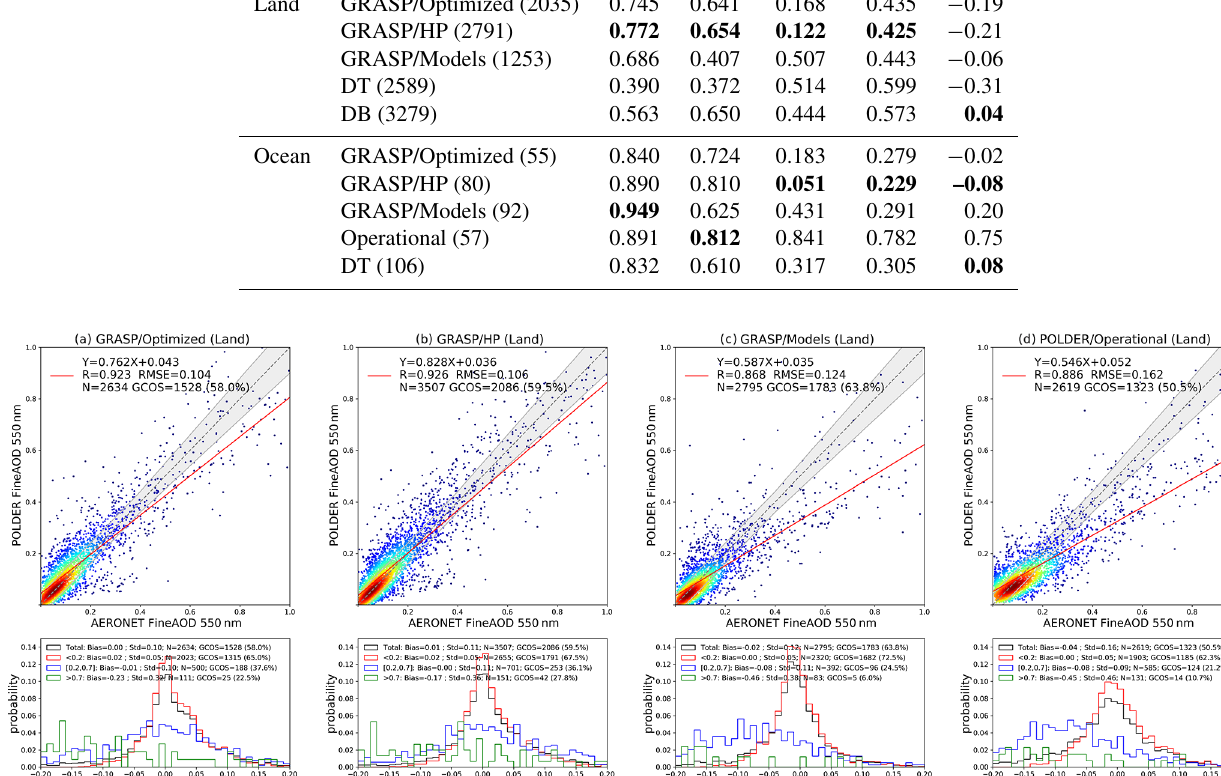
Figure 13. Validation of PARASOL/GRASP ( a GRASP/Optimized, b GRASP/HP and c GRASP/Models) and (d) PARASOL/Operational fine-mode AOD at 550nm over land in 2008. The gray envelope indicates GCOS requirement applied for AODF: max (0.04 or 0.1AODF). The probability density functions of differences (POLDER–AERONET) are present in the lower panels. The black, red, blue and green solid lines indicate all AODF conditions: any AODF, AODF < 0.2, 0.2 ≤ AODF ≤ 0.7 and AODF > 0.7,